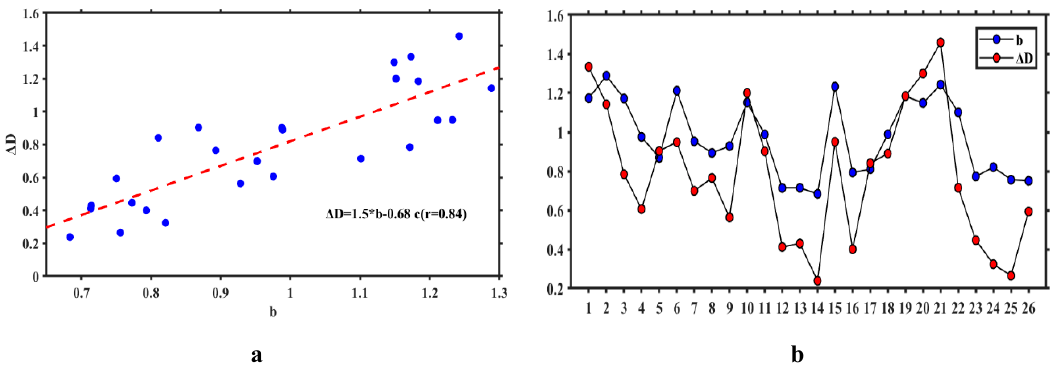
Figure 9. Relationship between the b value of the Gutenberg–Richter relation and the Δ D of the multifractal. a represents the relationship of regression fit between b and Δ D values; b represents the specific range of b and Δ D values.